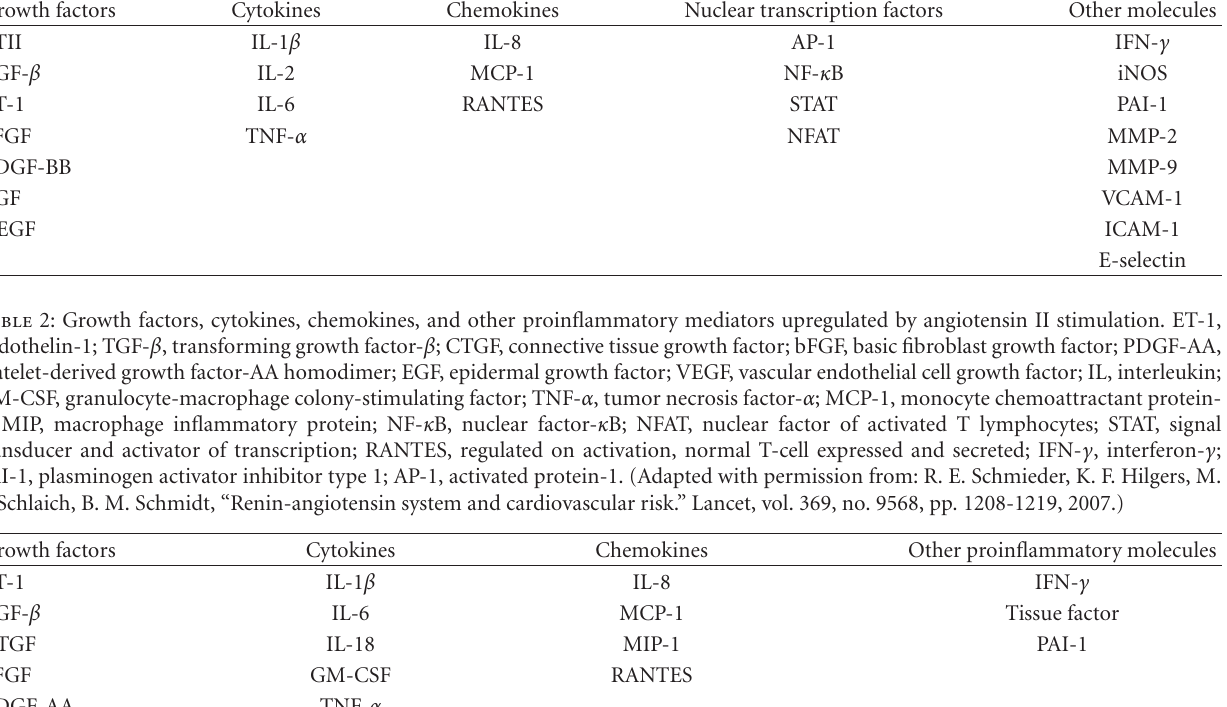
Table 1: Growth factors, cytokines, chemokines, and other proinflammatory mediators downregulated by PPAR γ activation. PDGF-BB, platelet-derived growth factor-BB homodimer; AP-1, activated protein-1; NF- κ B = nuclear factor- κ B; NFAT = nuclear factor of activated T lymphocytes; STAT = signal transducer and activator of transcription; ICAM, intracellular adhesion molecule; VCAM, vascular cell adhesion molecule; iNOS, inducible nitric oxide synthase. (Adapted with permission from: B. Staels, ”PPAR γ and atherosclerosis.” Current Medical Research and Opinion, vol. 21, Suppl. 1, pp. S13-S20, 2005; H. A. Pershadsingh, “Dual peroxisome proliferator-activated receptor- alpha/gamma agonists : in the treatment of type 2 diabetes mellitus and the metabolic syndrome.” Treatments in Endocrinology, vol. 5, no. 2, pp. 89-99, 2006.)